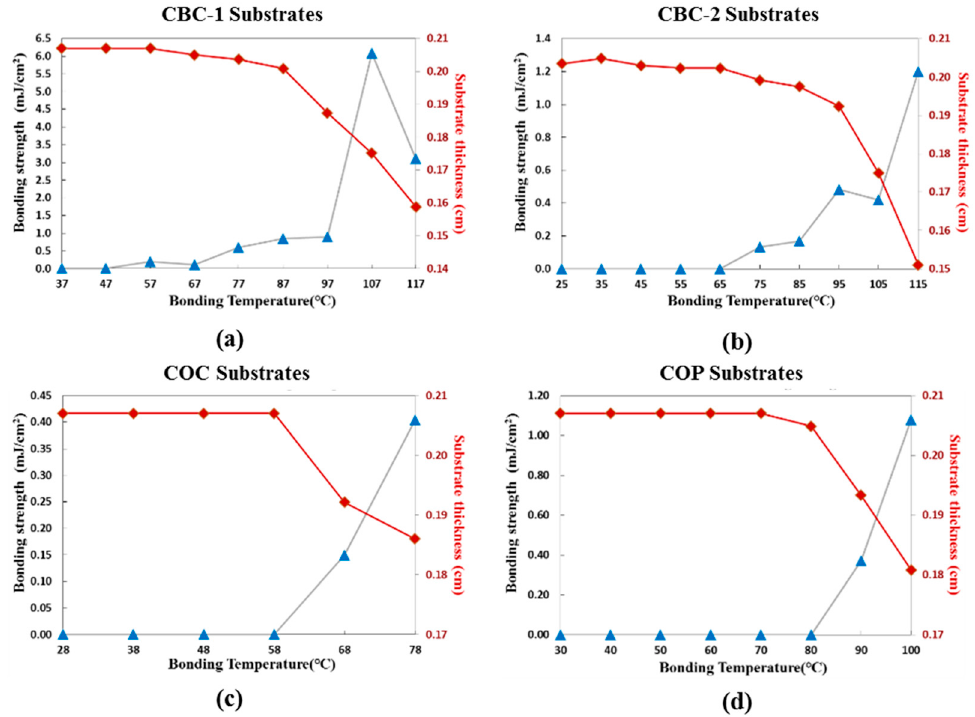
Figure 3. Thermoplastic bonding strength (blue line) and thermoplastic substrate thickness after bonding (red line) for various bonding temperatures for ( a ) CBC-1, ( b ) CBC-2, ( c ) COC, and ( d ) COP. ( e ) Complex viscosity measurement for CBC-1, COC, and COP. The bonding strength and substrate thickness values are averaged on the basis of three individual measurements; ( f ) Microchannels injected with a blue food dye (15 µL/min). No microchannel collapse can be observed under optimal bonding conditions. The bonding strength drop at 117 °C for CBC-1 was because the polymer stuck to the glass during the release of bonded pairs. The operating conditions when the complex viscosity was measured were 250 °C, strain: 5% in N 2 gas. The UV/ozone treatment modifies the thermoplastic surface by altering the surface wettability of the microchannel, which is a key consideration for microfluidic applications. After UV/ozone surface treatment, surface hydrophobicity variations were evaluated. Figure 4 presents water contact angles and UV/ozone surface treatment time. CBCs exhibited weak hydrophobicity of 97.20° (CBC-1, blue line in Figure 4) and 98.81° (CBC-2, orange line in Figure 4) in native stages. Under the UV/ozone surface treatment, the water contact angle on CBC surfaces decreased to 49.97° (CBC-1) and 58.14° (CBC-2) within 10 min. After 10 min, it plateaued and gradually reduced the water contact angle as surface treatment increased.